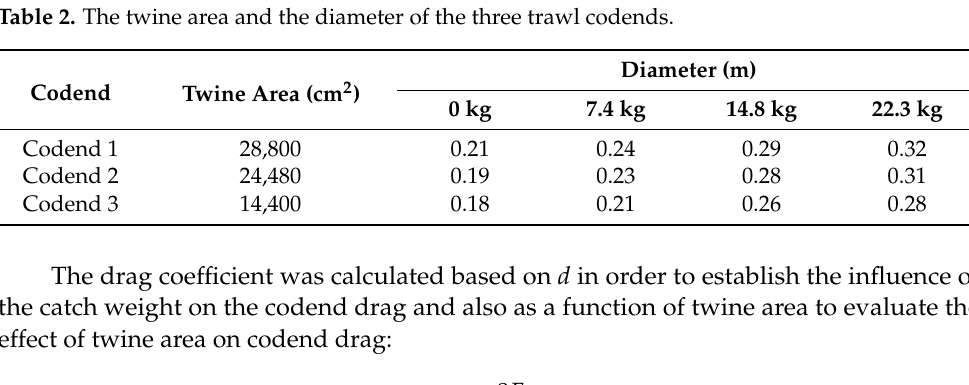
Table 2. The twine area and the diameter of the three trawl codends.